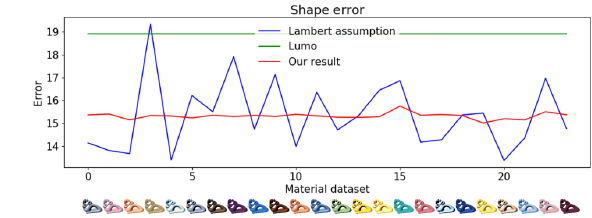
Fig. 13 Errors of estimated shape depending on input material (medium complexity shape Fertility ).